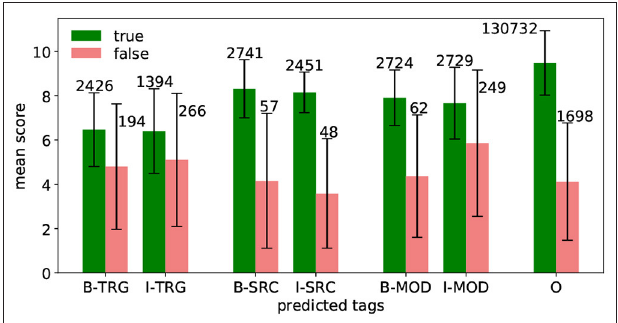
FIGURE 3 | Prediction margin of predicted tags using five-fold cross validation on aVA.